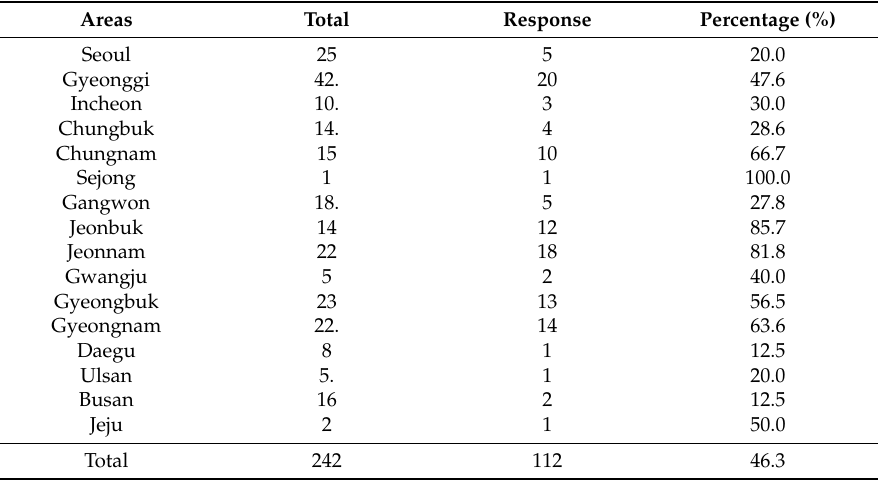
Table 1. The response by local governments regarding the TKM services provided by